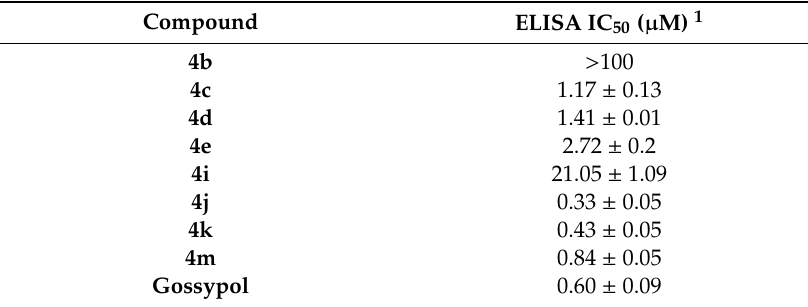
Table 2. ELISA binding activity IC 50 values for selected 2-(1 H -indol-3-yl)-5-substituted-1,3,4- oxadiazoles compared to positive control